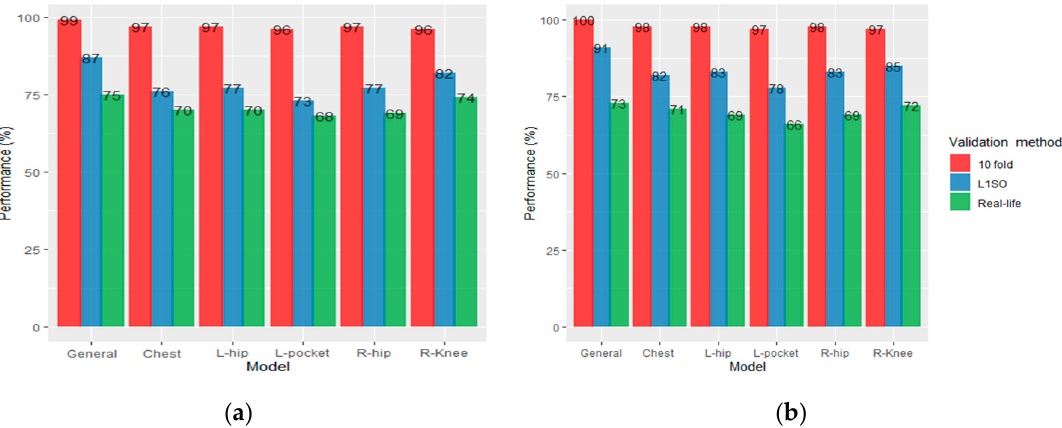
Figure 3. Overall accuracy of the RF classification models trained with semi-structured data, ( a ) accelerometer data only and ( b ) accelerometer and GPS data.